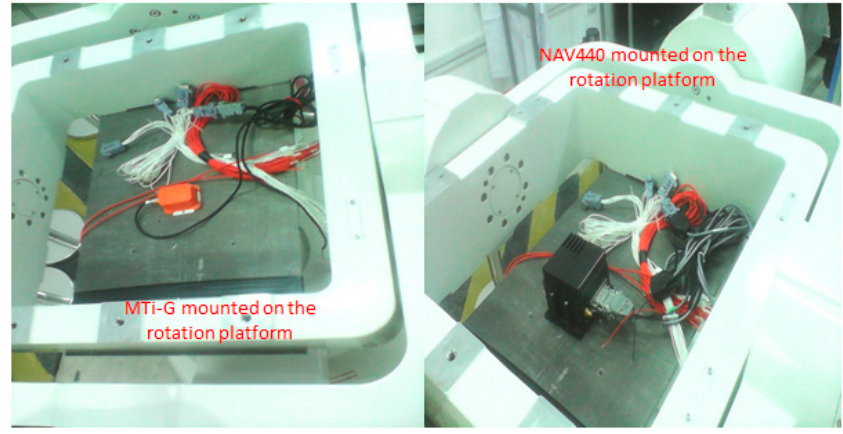
Figure 3. Tri-axial rotation platform.